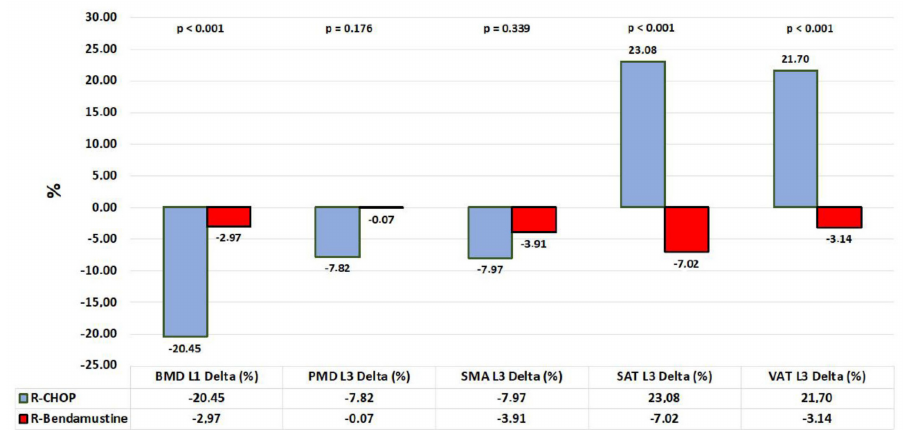
Figure 3. Graphical representation of “delta” mean values stratified by R-CHOP vs. R-Bendamustine therapy.